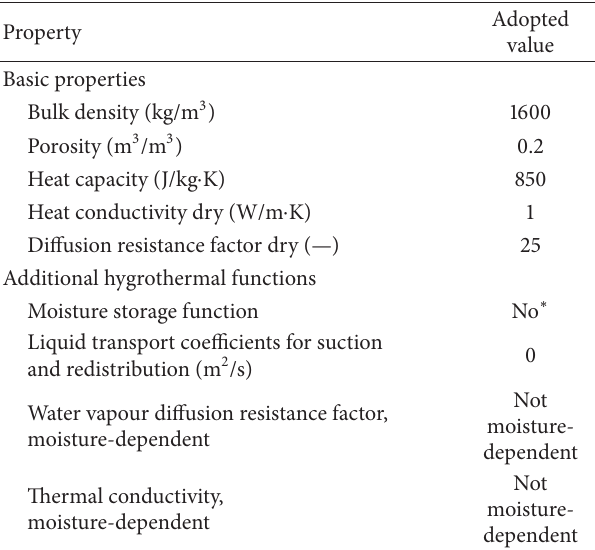
Table 2: Properties of the exterior rendering (resin finishing coat).